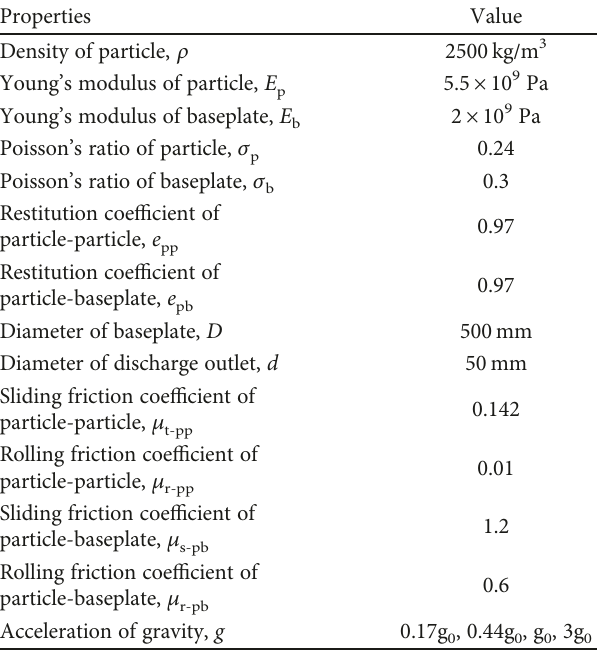
Table 1: Parameters used in the